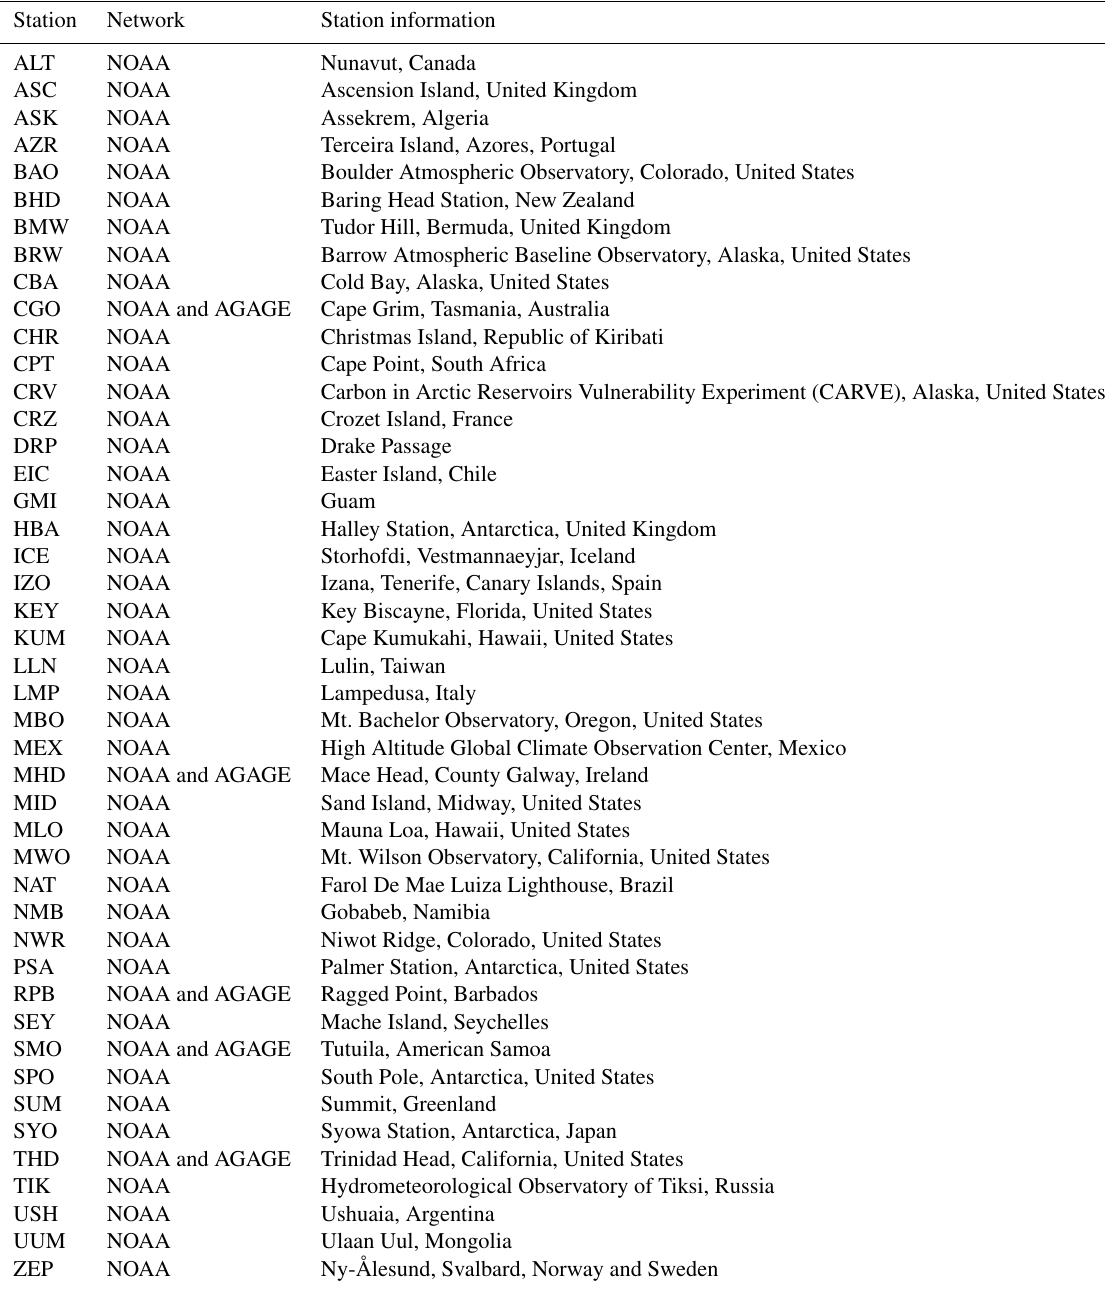
Table 1. Surface stations included in the inversion. Locations of the stations are shown in Fig. 2.